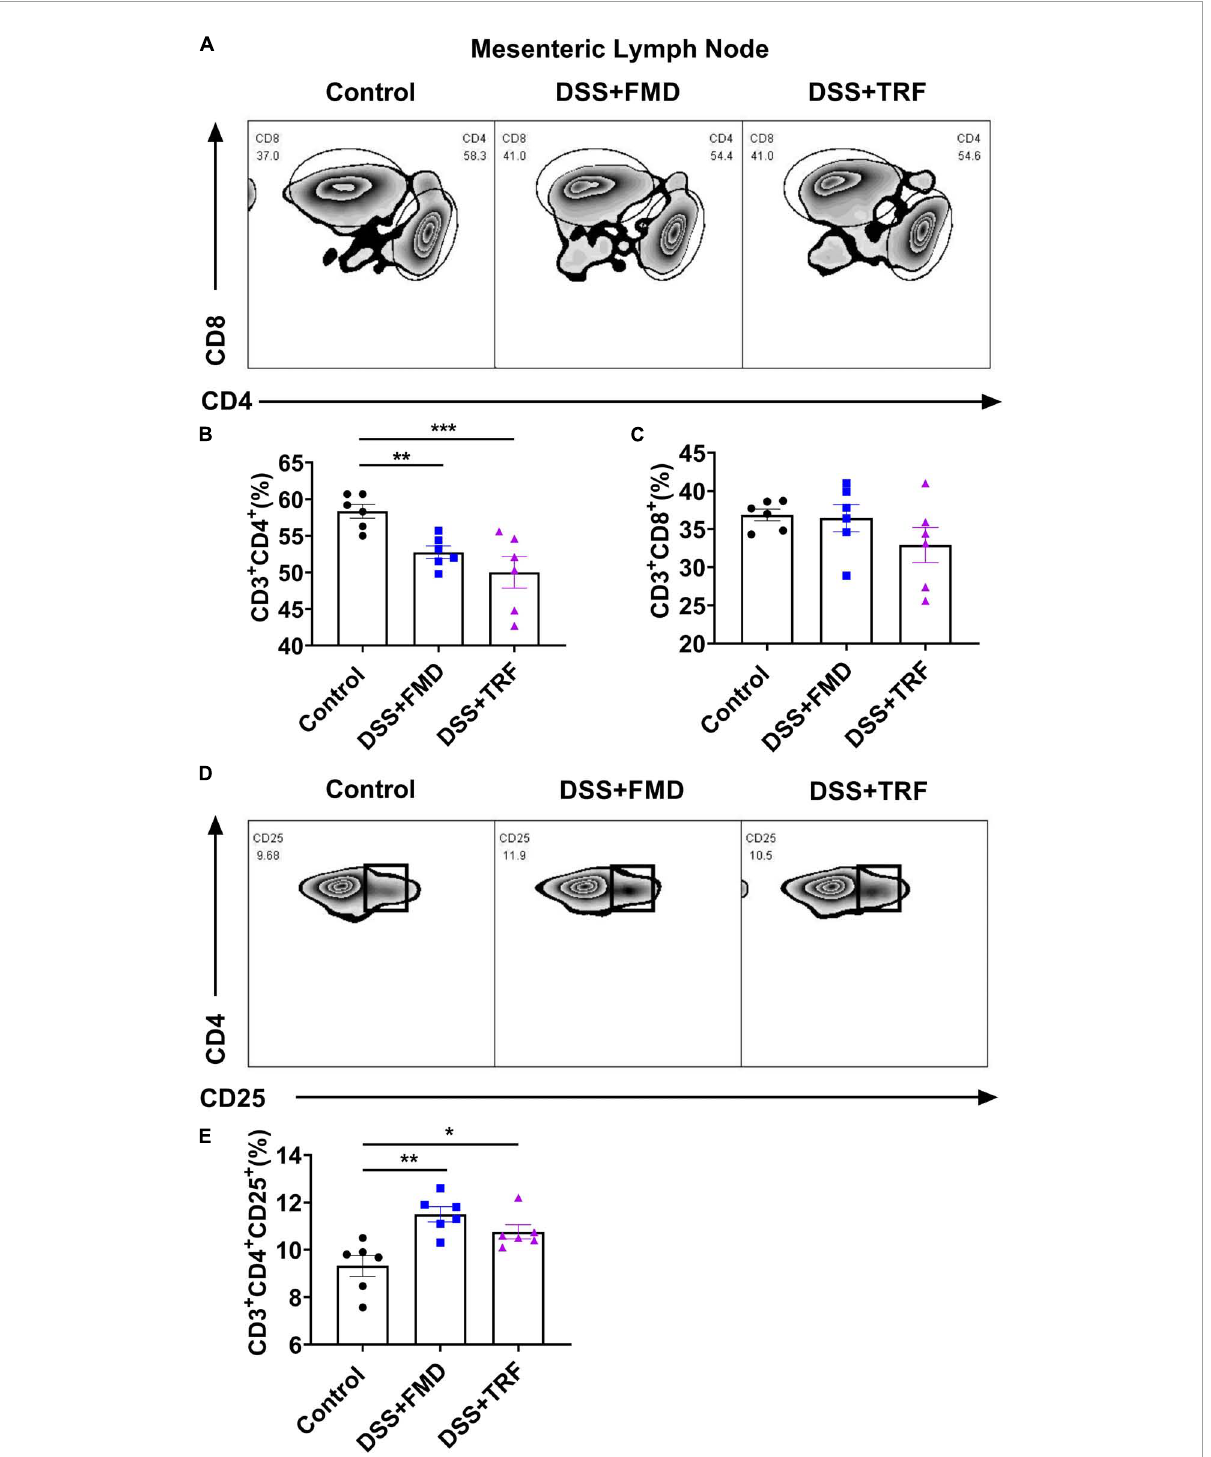
FIGURE4 TRF alters the T cells profile in the mesenteric lymph nodes. (A) Results of flow cytometry analysis for CD4 + and CD8 + T cells in the mesenteric lymph nodes at the end of experiment ( n = 6 for each group). (B) Percentage of CD4 + T cells in the mesenteric lymph nodes. (C) Percentage of CD8 + T cells in the mesenteric lymph nodes. (D) Results of flow cytometry analysis of CD4 + CD25 + T cells in the mesenteric lymph nodes ( n = 6 for each group). (E) Percentage of CD4 + CD25 + T cells in the mesenteric lymph nodes. Data are presented as mean ± SEM; * P < 0.05, ** P < 0.01, *** P <